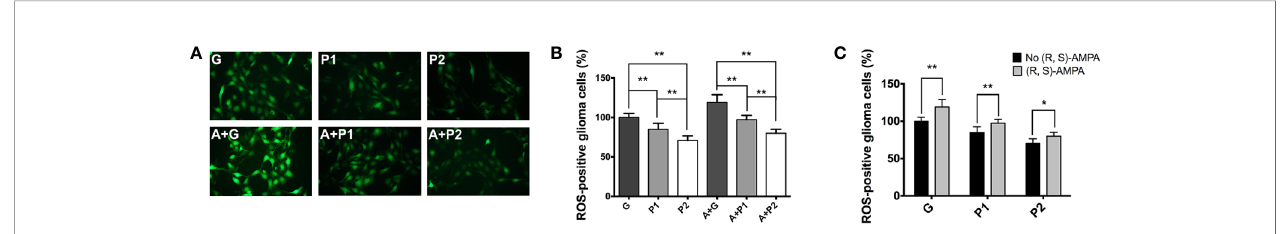
FIGURE 5 | Oxidative stress status was investigated using ROS assay. (A) Fluorescence image of cellular ROS productive levels (magni fi cation, ×200). (B, C) Quanti fi cation of ROS levels in the gliomas. Data are presented as the mean ± SD (n=6/group). *P < 0.05 and **P < 0.01. Groups: S, sham; G, glioma; P1 and P2, propofol 1.2, and 4.4 µg/ml -1 , respectively; A, (R, S)- AMPA. ROS, reactive oxygen species; AMPA, a -amino-3-hydroxyl-5-methyl-4-isoxazolepropionic